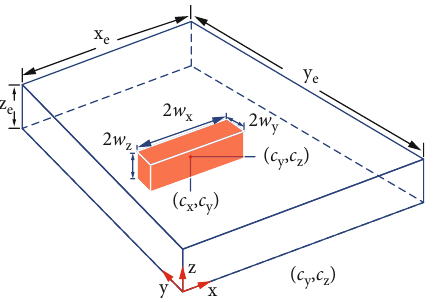
Figure 2: Schematic of the volume source in closed boundaries.